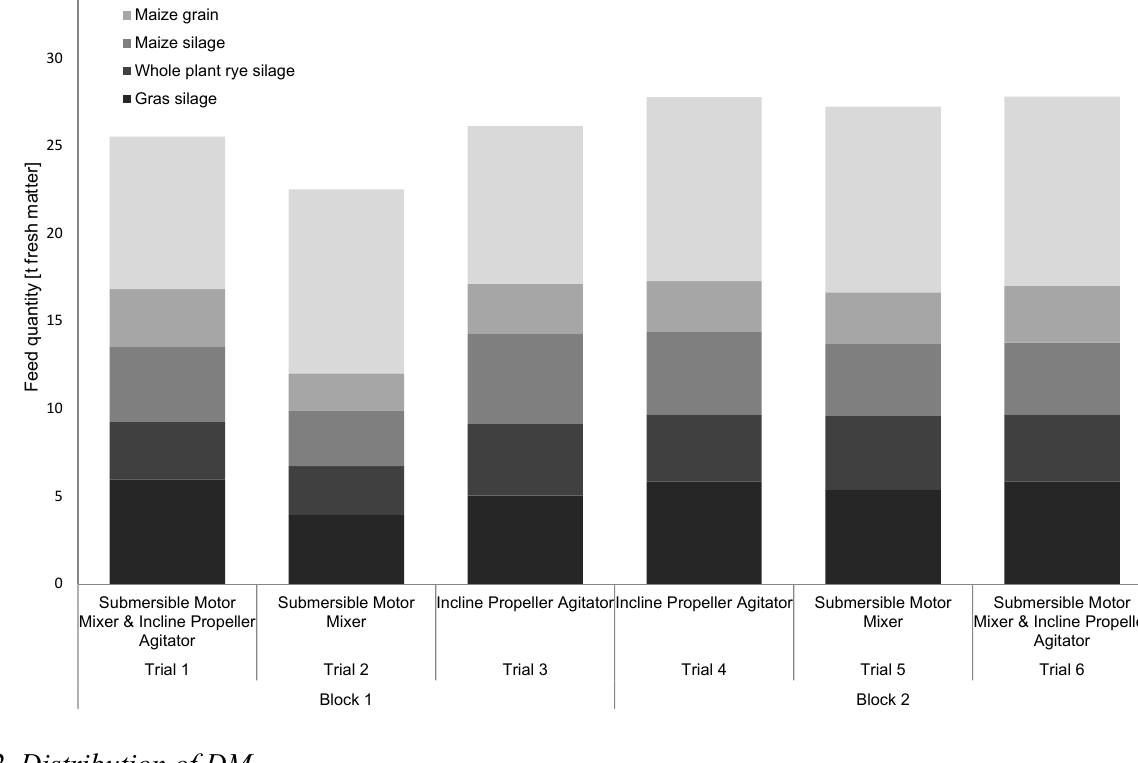
Figure 4. Feed supply and proportioning during the three days lasting trial periods.